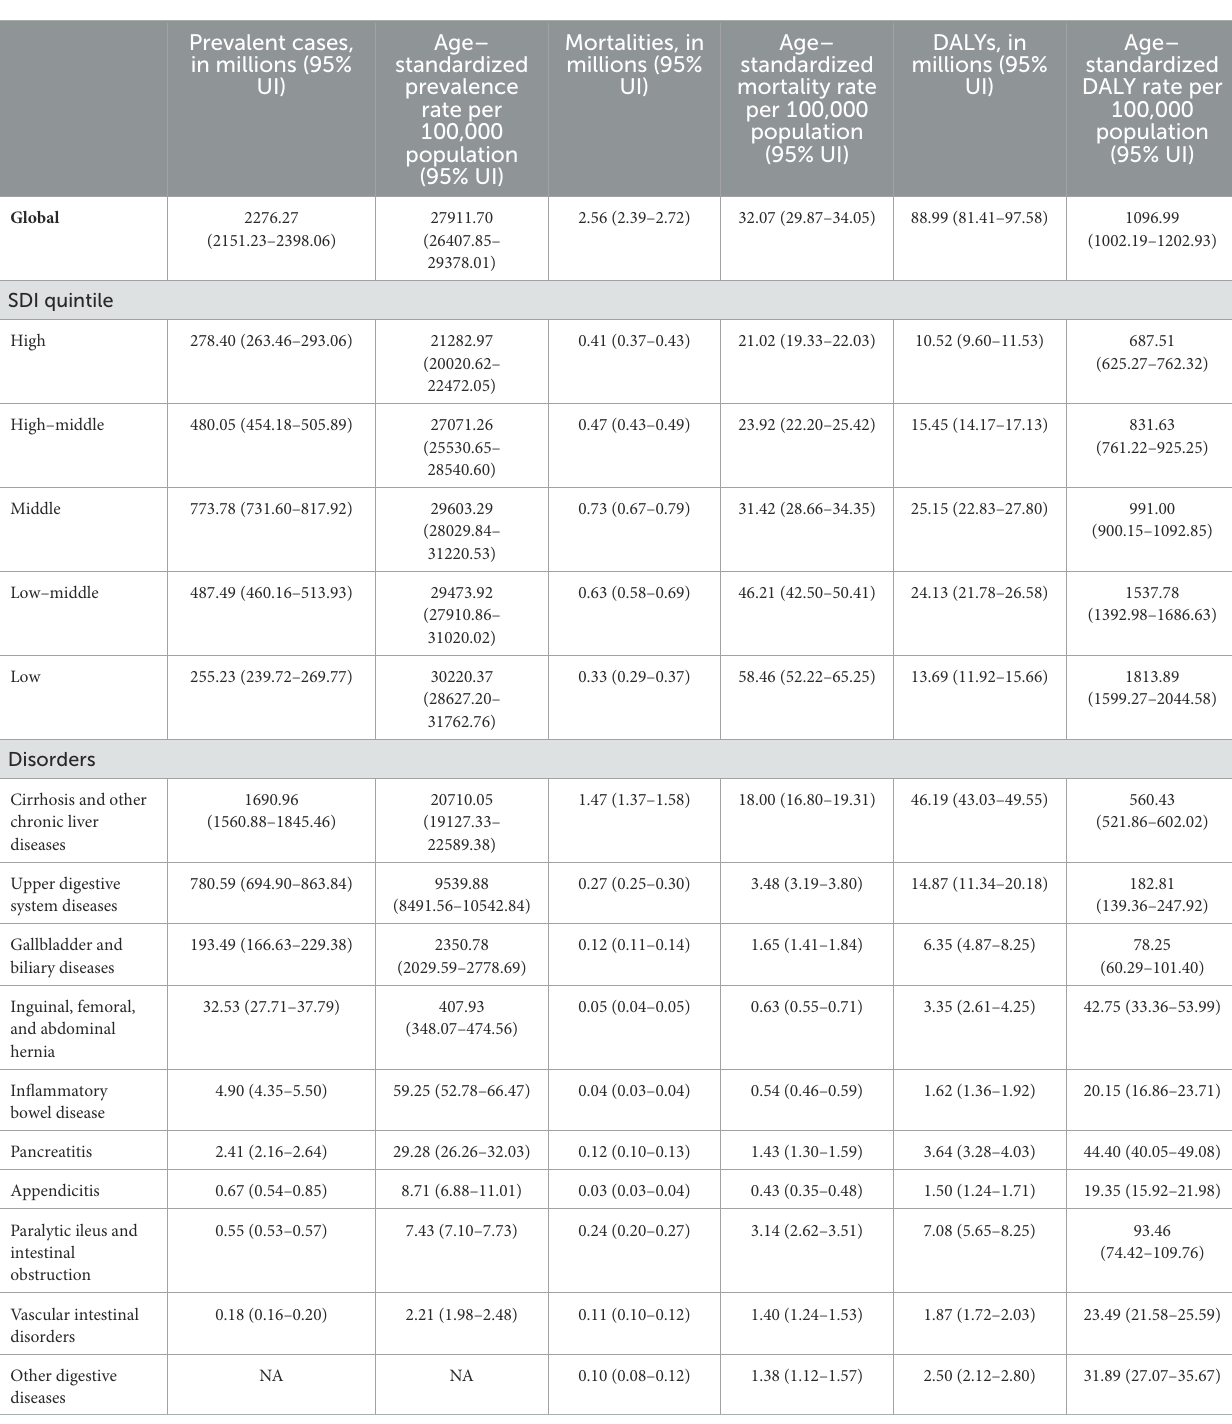
TABLE 1 Prevalent cases, mortalities, disability-adjusted life-years (DALYs) and their age-standardized rates due to digestive diseases in 2019 for both